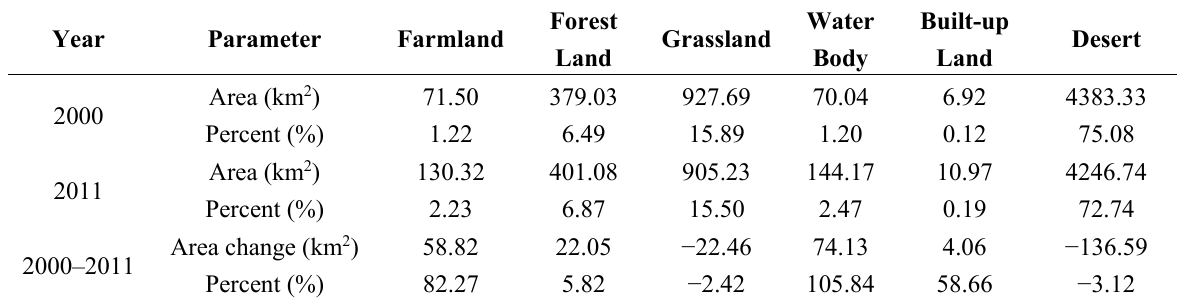
Table 1. Changes in primary types of land use in the Ejin Oasis.